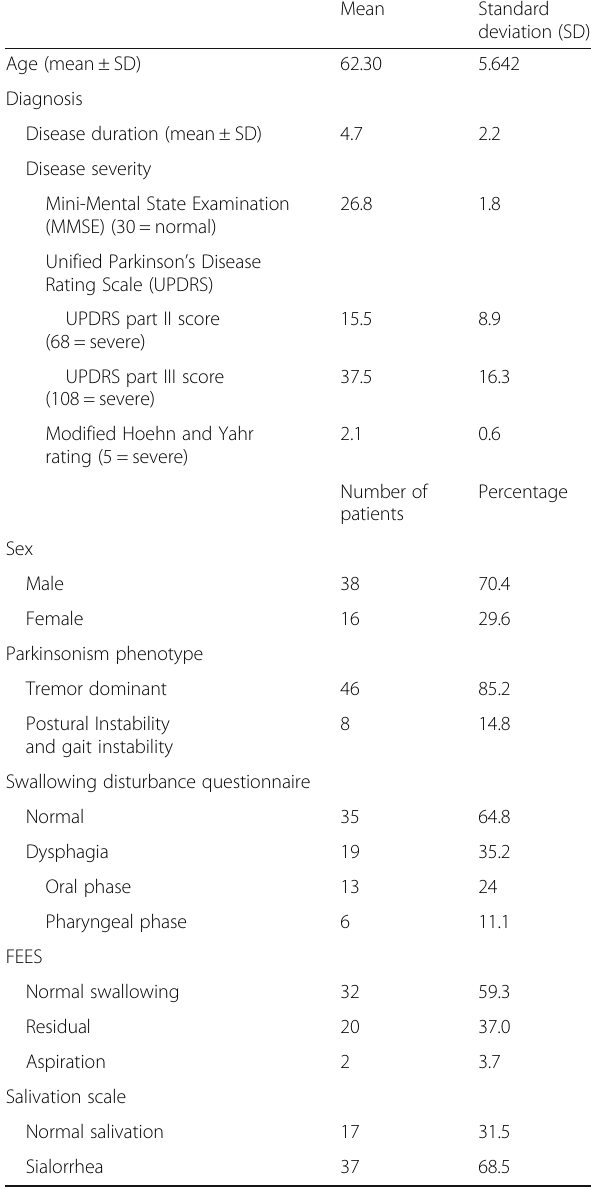
Table 1 Baseline characteristics of patients with